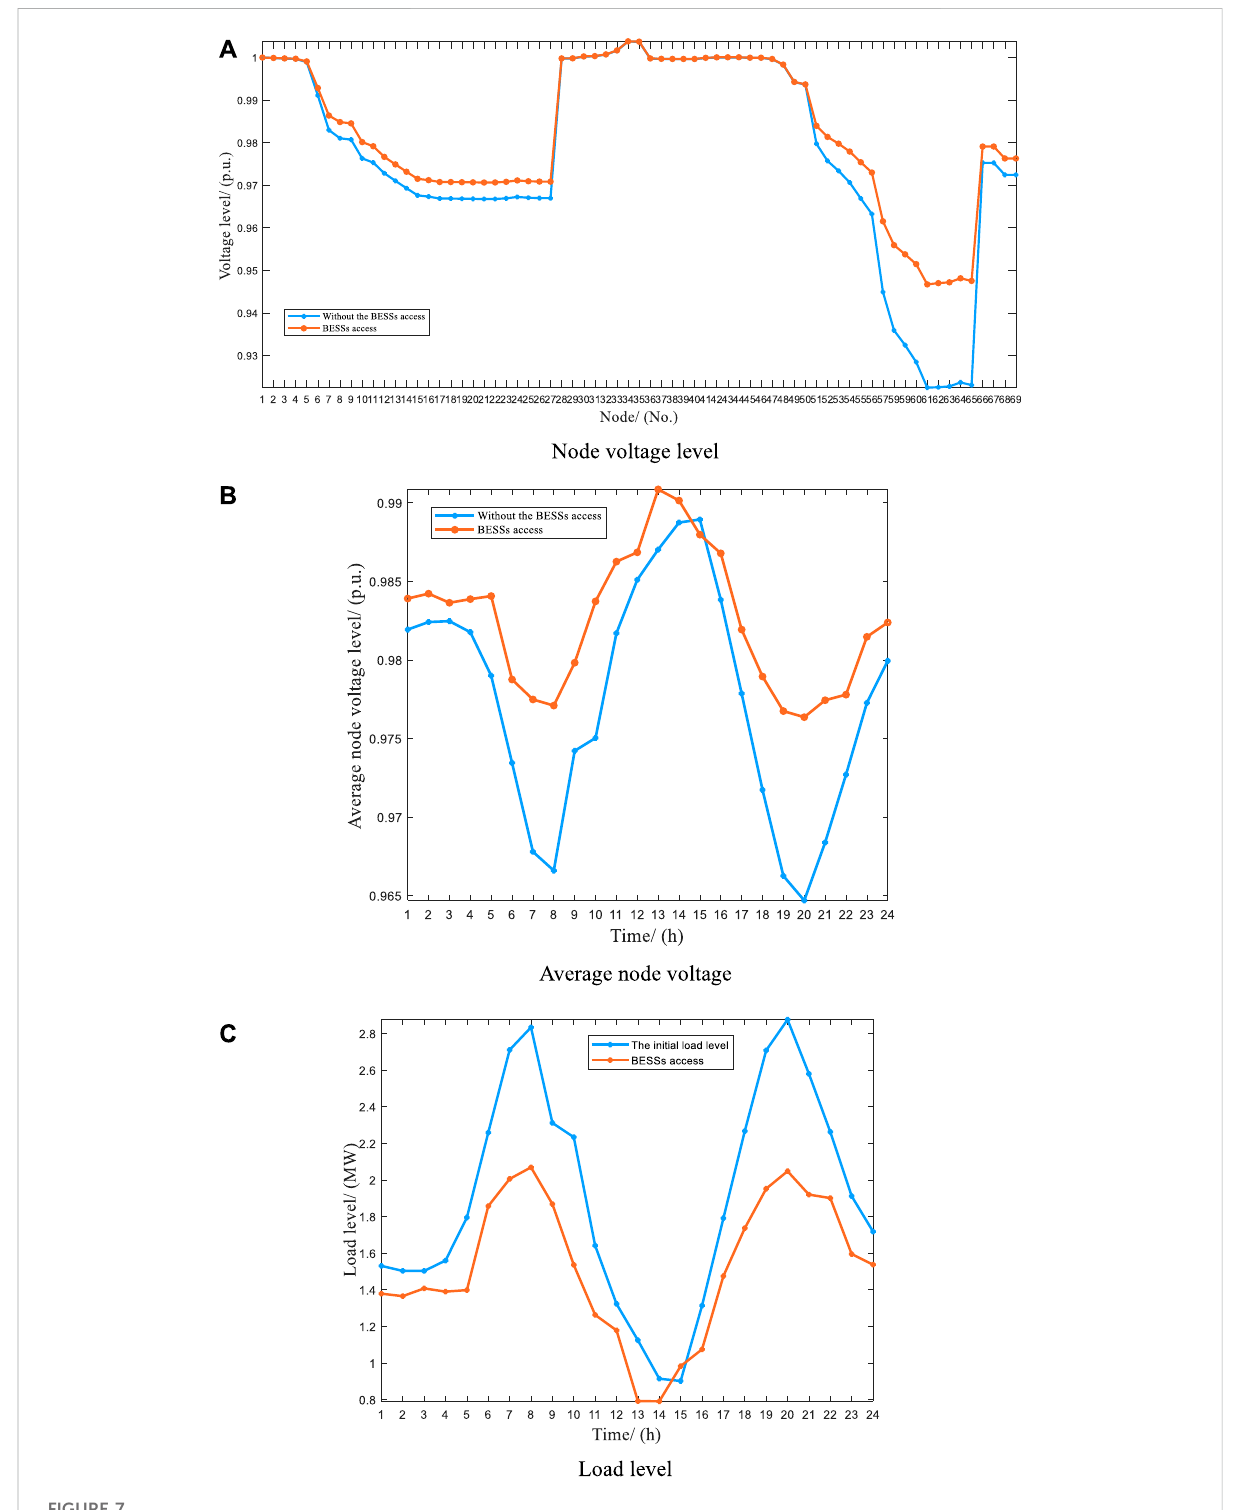
FIGURE 7 Optimization results of network obtained by NSGA-II under the extended IEEE-69 node test system. (A) Node voltage level. (B) Average node voltage. (C) Load